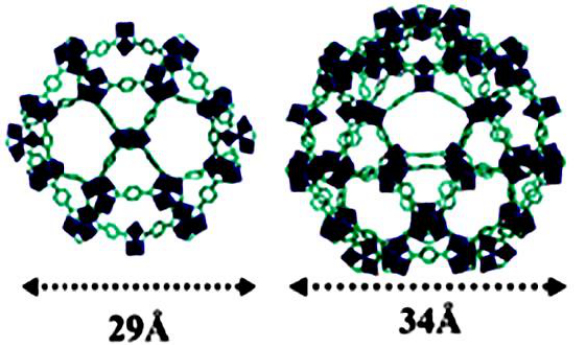
Figure 1. Two types of cages present in the structure of MIL-101(Cr). Reprinted with permission from reference [34]. Copyright 2017 Royal Society of Chemistry.